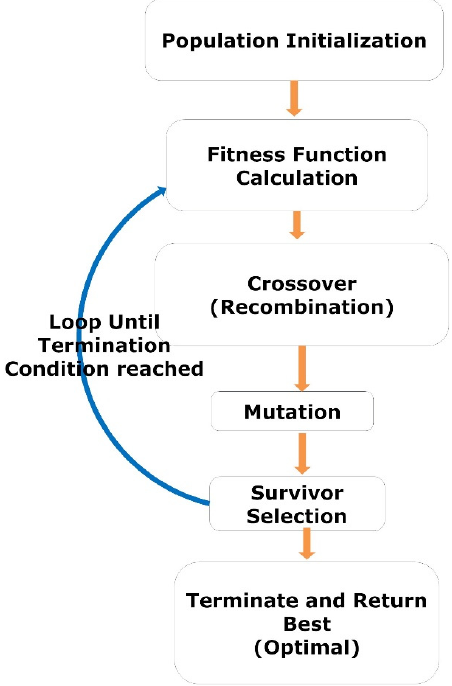
Figure 3. The workflow represents the steps of